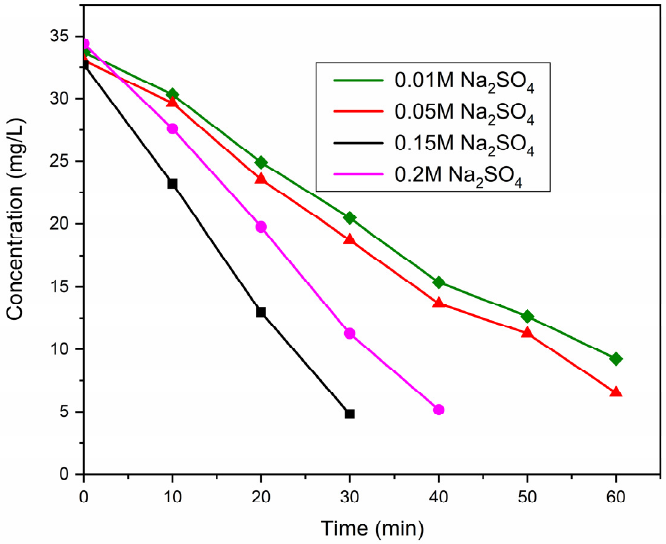
Figure 4. Degradation of RB5 dye under pH 2 and different concentrations of Na 2 SO 4 .